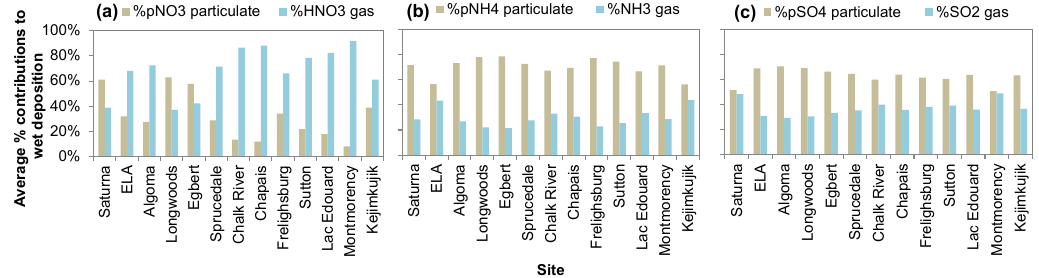
Figure 9. Average percent contributions of gas- and particulate-phase species to nitrate (a) , ammonium (b) , and sulfate (c) wet deposition.